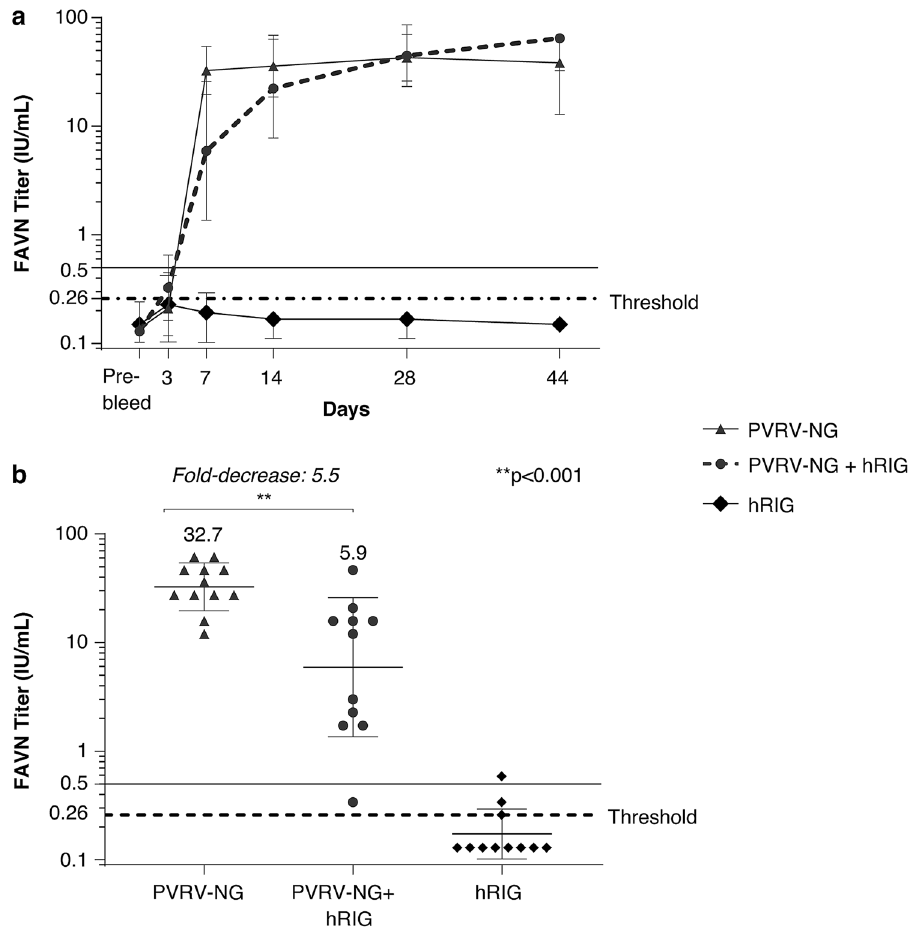
Figure 2. Immunogenicity of PVRV-NG vaccine in presence of human rabies immunoglobulin (hRIG) administered by intramuscular (IM) injection according to post-exposure prophylaxis regimen. In the preliminary experiment to set up the animal model , adult female hamsters (n = 12 per group) were vaccinated on Days 0, 3, 7, 14, and 28 by IM injection with 1:5 Human Dose of PVRV-NG in one group, and co-injected with hRIG (20 IU/kg) on Day 0 in another group. ( a ) Serum rabies virus neutralizing antibody (RVNA) levels were monitored by performing a fluorescent antibody virus neutralization test (FAVN) on blood samples collected on Days -7 (7 days prior to Day 0; pre-bleed), 3, 7, 14, 28, and 44. The lower level of detection in FAVN was of 0.26 IU/mL as shown by the dotted line. The continuous black line indicating 0.5 IU/mL is the WHO specified standard serum RVNA titer considered as an adequate immune response to rabies vaccination in humans. Data are expressed as the mean ± SEM. ( b ) Serum RVNA titers measured 7 days after the first